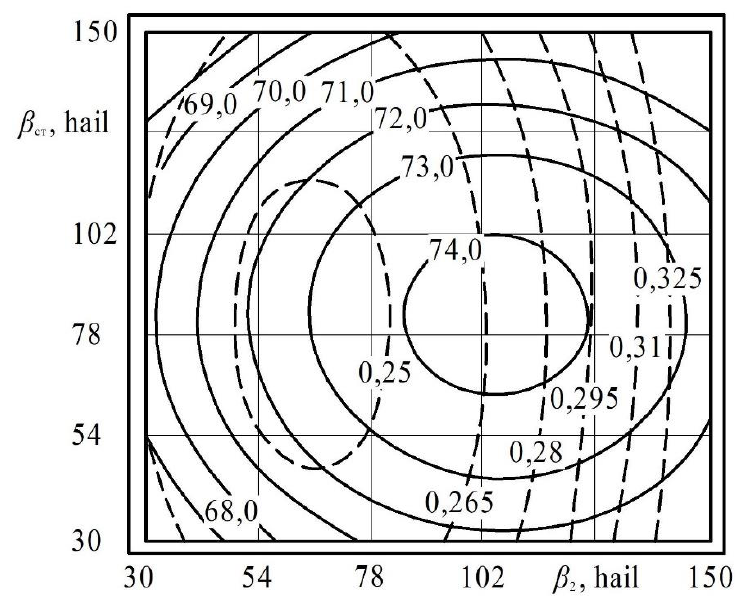
Figure 12. Two-dimensional section of the response surface of the degree of homogeneity ( –––– ) and the consumption of electrical energy (- - - - -) from the angles of the impeller and stationary blades. The two-dimensional section shows that the smallest consumption of electrical energy was achieved with a combination of factors β 2 = 50 . . . 80 ◦ , β st = 48 . . . 110 ◦ and the